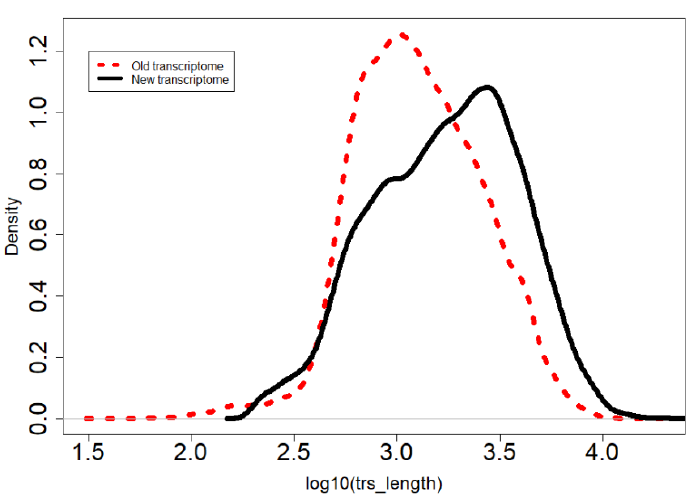
Figure 1. The transcript length distribution of the new ( solid line ) and old ( discontinuous line ) transcriptomes. The new version has fewer and longer transcripts.